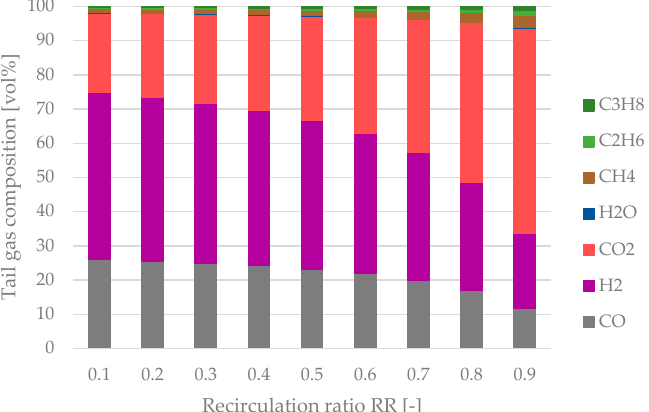
Figure 10. Tail gas composition as a function of the recirculation ratio RR for the process configuration without a tail gas reformer.